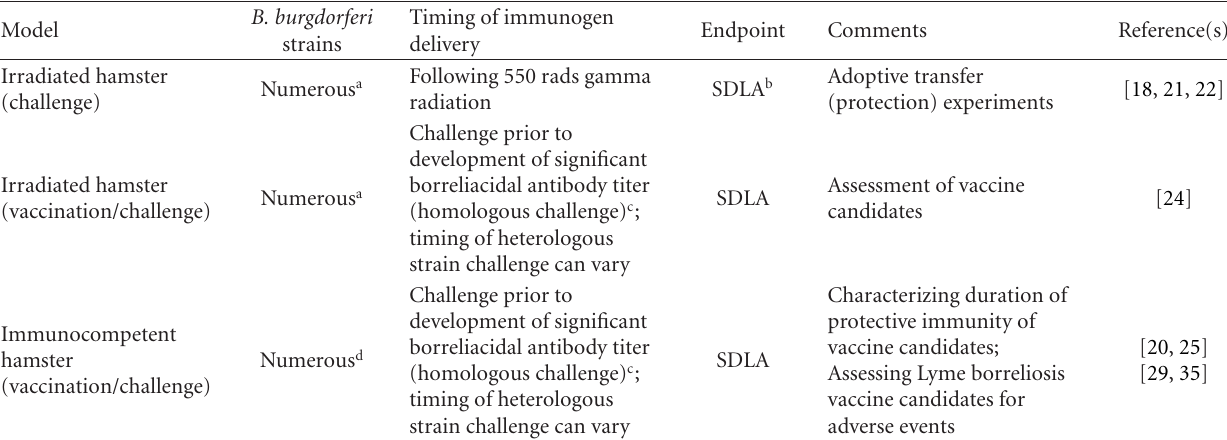
Table 2: Hamster models important for evaluation of protective immunity versus endpoint of severe destructive Lyme arthritis.